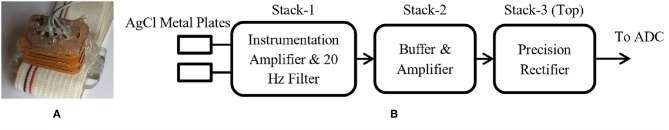
Stacked sEMG electrode (A) and its architecture (B).